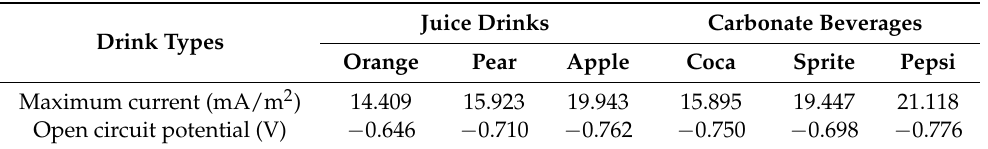
Table 3. Maximum current and open circuit potential of the AFC anode with different sweet drinks as substrate. Juice Drinks Carbonate Beverages Drink Types Orange Pear Apple Coca Sprite Pepsi Maximum current (mA/m 2 ) Open circuit potential (V) − 0.646